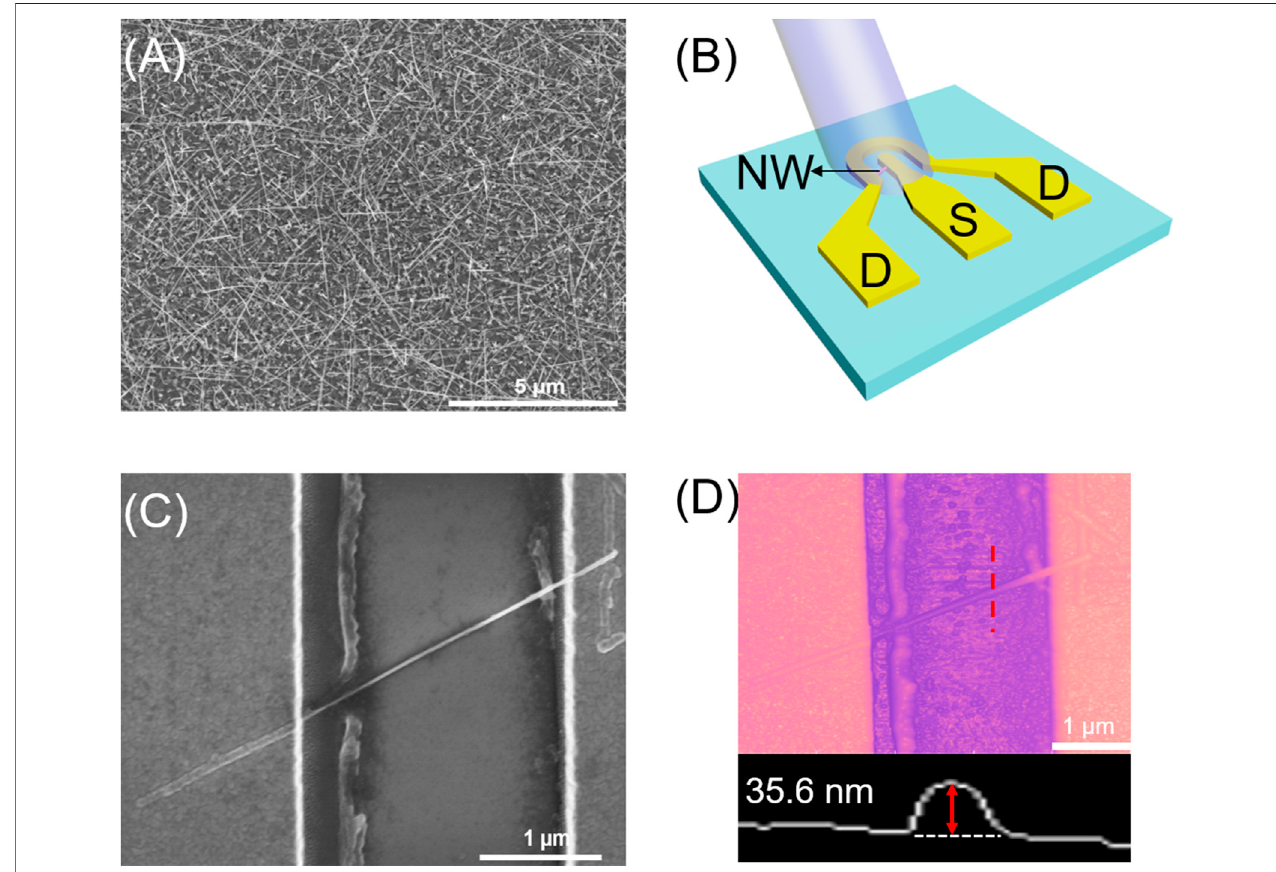
FIGURE1|(A) SEMimageoftheas-grownInAsNWstotransfer.Thescalebar is5 μ m; (B) 3Dschematicdiagramofthedevicestructure; (C) SEMimage and (D) AFM image of the as-fabricated InAs NW photodetector. The scale bar is 1 µm.